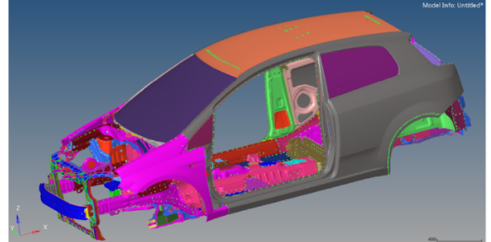
Figure 1. Body in white configuration.